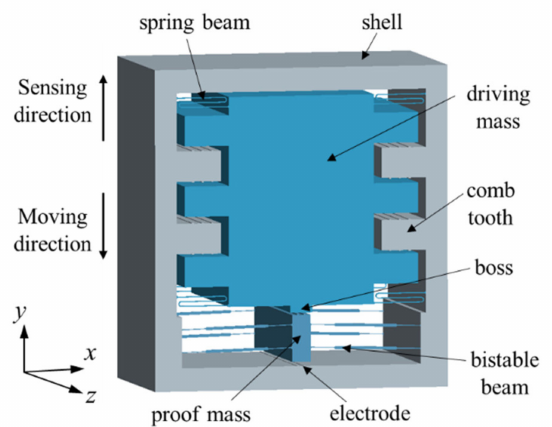
Figure 9. Schematic and structural parameters of the designed MEMS bistable inertial